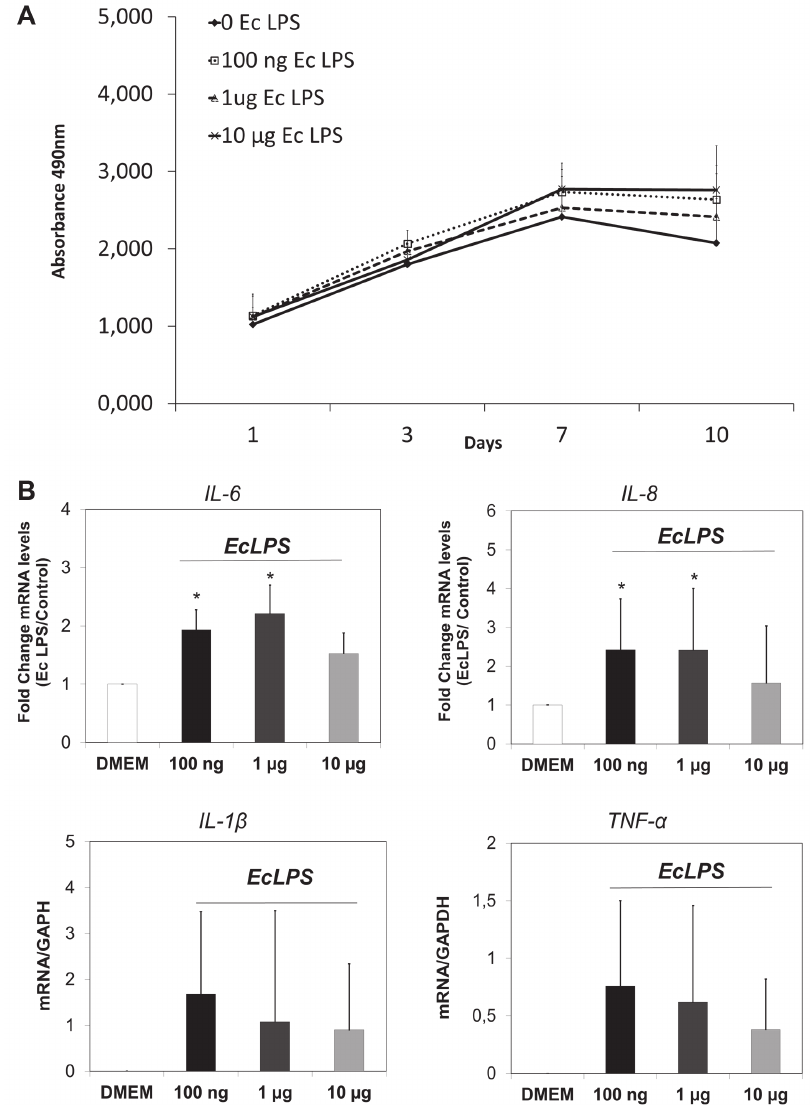
Figure 3- Effect of E. coli lipopolysaccharide (LPS) on the viability and pro-inflammatory cytokines expression. (A) PDL- CD105 + cells were cultured in the presence of EcLPS at concentrations of 0, 100 ng, 1 µg and 10 μg/ml. Metabolic activity as an indicator for cell viability was measured with MTS assay at the following time points: 1, 3, 7 and 10 days. (B) Real- time PCR showed an increase of mRNA levels of IL-6, IL-8, IL-1β and TNF- α , respectively, in PDL-CD105 + cells after 24 hours of EcLPS exposure. Representative data of three independent experiments are shown. Statistical significance intergroup is indicated by *